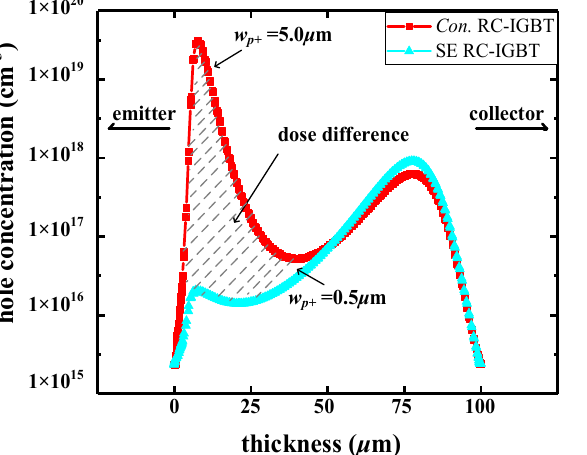
Figure 3. Hole density distribution of Conventional RC-IGBT along line AA’ and SE RC-IGBT along line BB’.